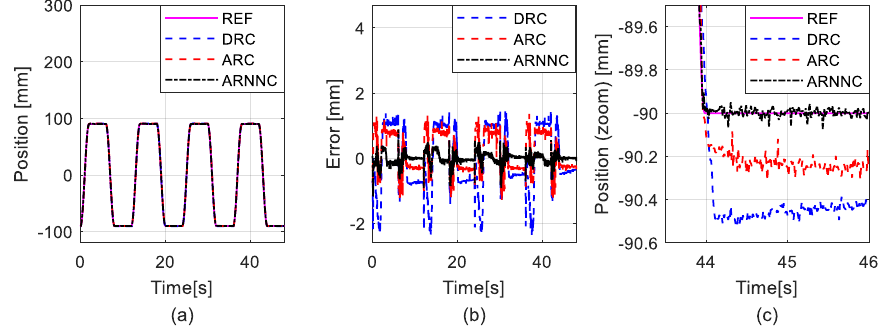
Figure 4. Tracking performances of smoothed-step ( a ) Smoothed-step tracking responses of different controllers. ( b ) Tracking errors of different controllers. ( c ) Zoomed responses from 43.5 to 46 s.